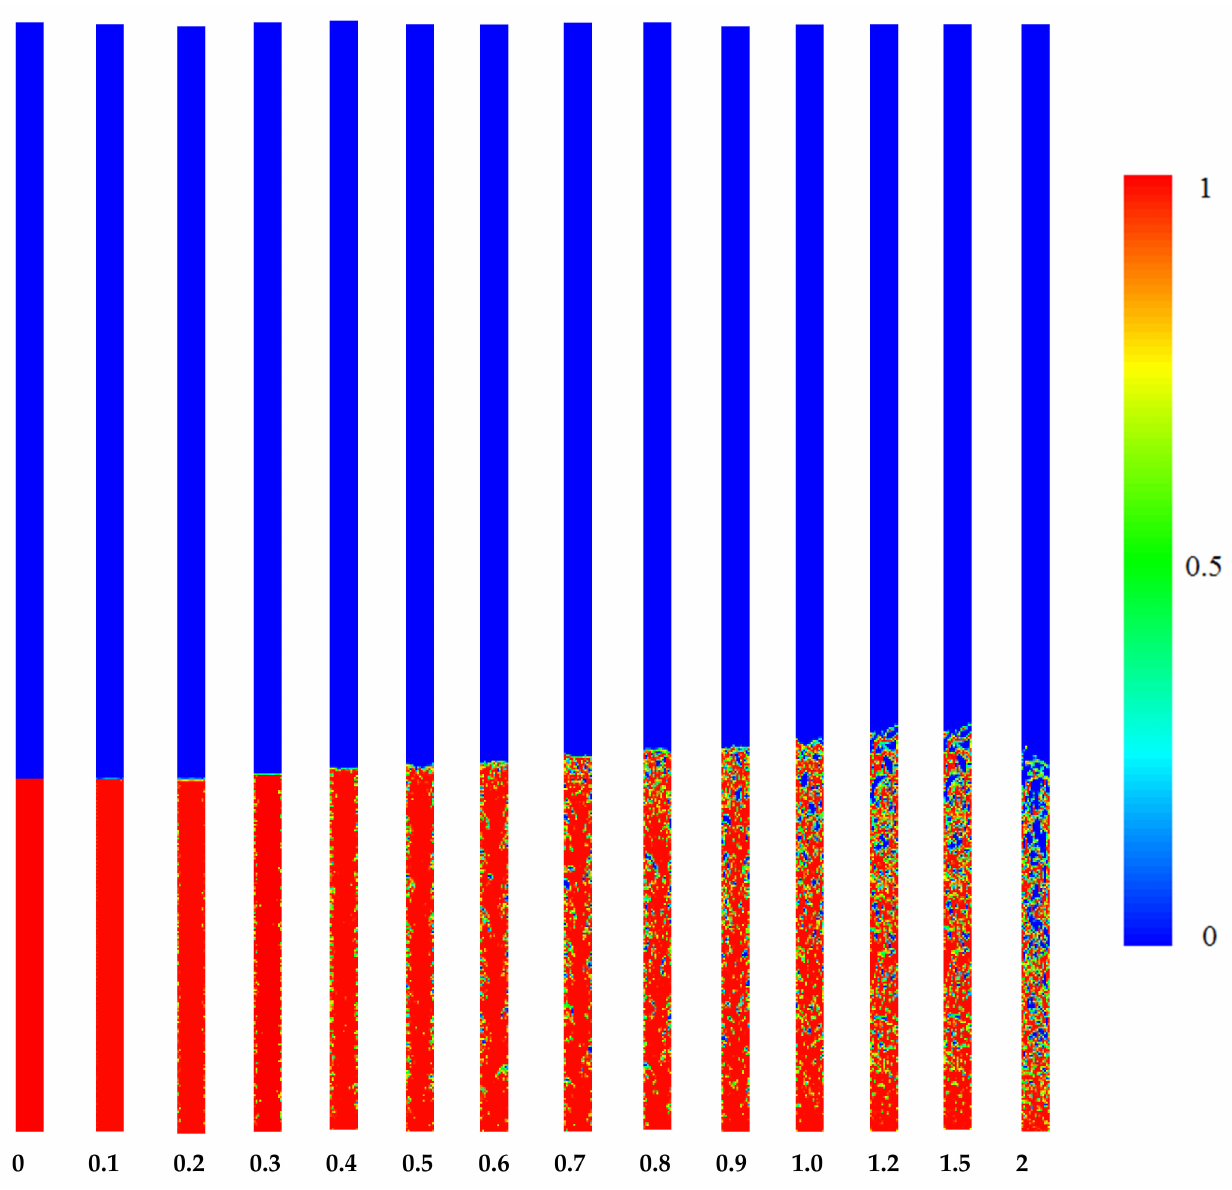
Figure 6. Contours of volume fraction in entire parts of TPCT at different times for FR =